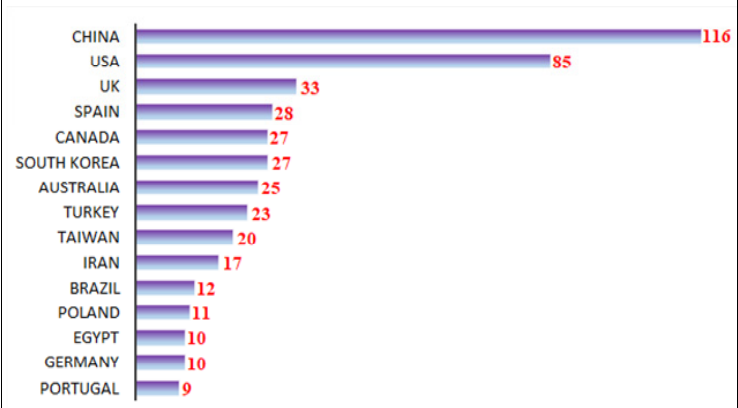
Figure 8. Number of articles published in the top 15 countries.